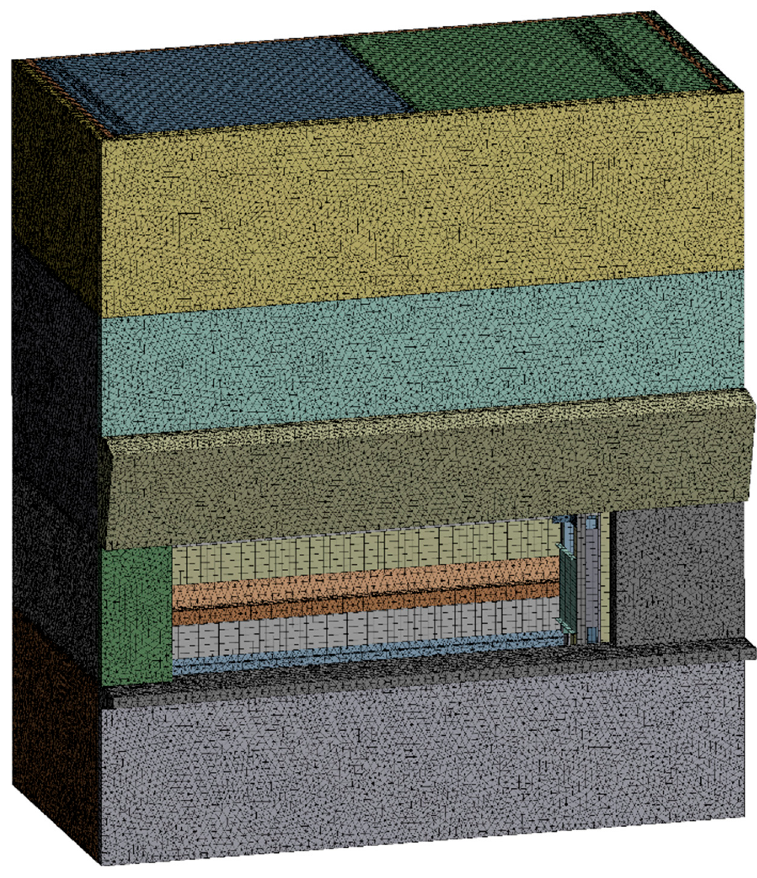
Figure 5. Mesh Figure 5. Mesh Division.